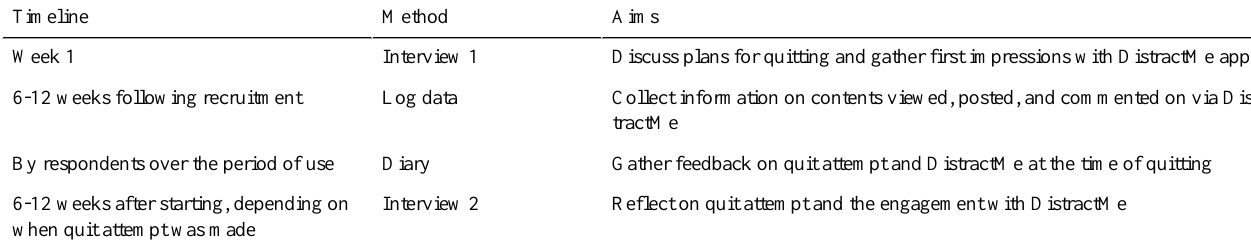
Table 1. Methods used during the 6-week field